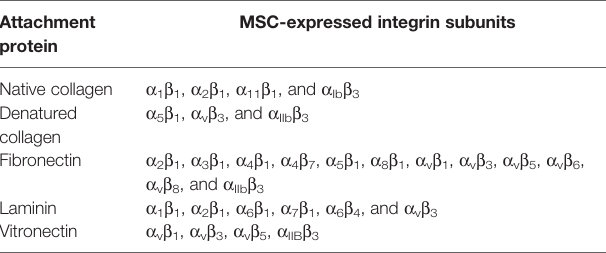
TABLE 2 | MSCs express integrin heterodimers that attach to speci fi c media proteins (Plow et al., 2000, Docheva et al., 2007, Niehage et al., 2011). Attachment MSC-expressed integrin protein